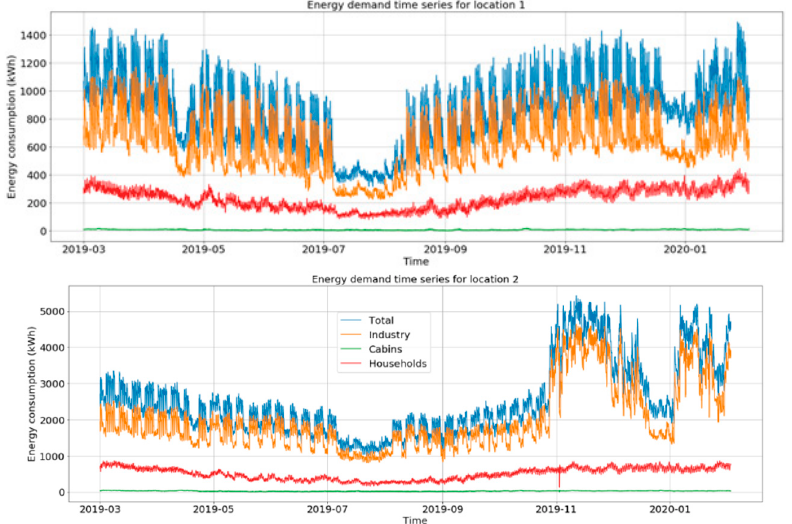
Figure 2. Real-world time series of consumption for location 1 and 2. The demand for the industry sector is strongly correlated with the fishing season, while the energy demand for households is correlated with temperature changes, where cold temperatures during wintertime give higher energy demand for heating purposes.